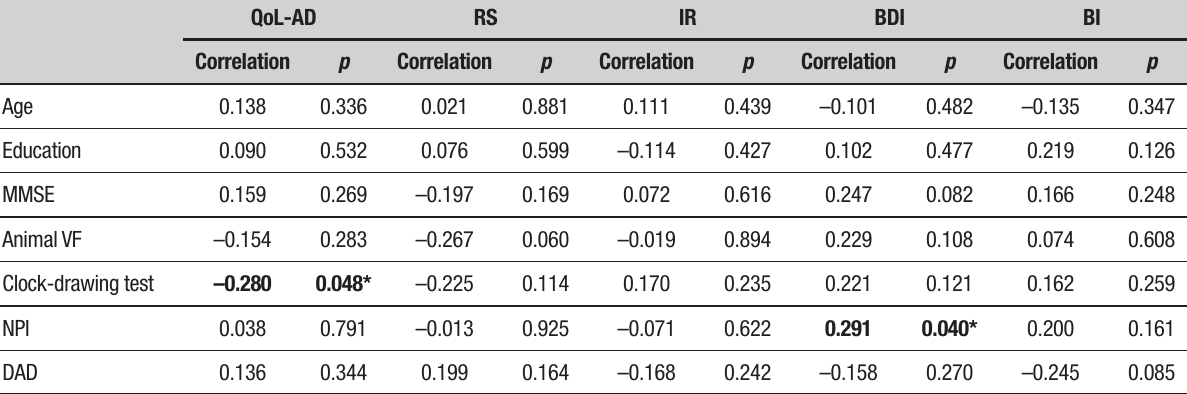
Table 3. Correlation among scores on the QoL-AD, RS, IR (DUREL-P), BDI and BI of the family caregiver and age, education, cognitive, NPI and DAD scores of the elder with dementia.